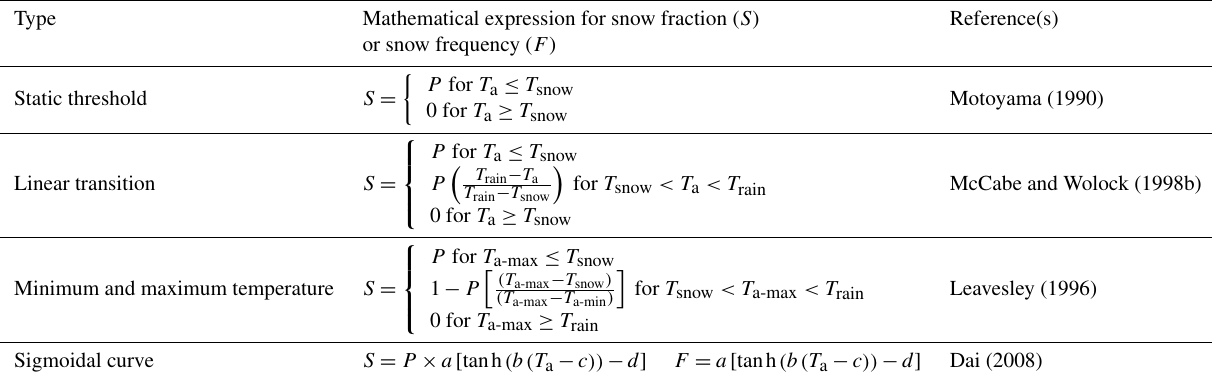
Table 1. Mathematical expression for the four common temperature-based PPM to estimate snow fraction ( S ) or snow frequency ( F ) using the mean air temperature ( T a ) , maximum daily air temperature ( T a-max ) , and/or minimum daily air temperature ( T a-min ). The variable T snow is air temperature when all precipitation ( P ) is snow and T rain is the air temperature when all air precipitation is